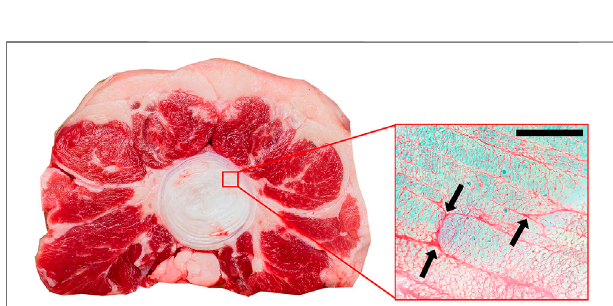
FIGURE 5 | Axial view of annulus fi brosus stained with Safranin O/Fast Green (×10 magni fi cation). Arrows indicate regions of inconsistent adhesion between adjacent lamellae. These regions are generally where one collagen bundle ends and an adjacent one begins. Scale bar 500 µm.